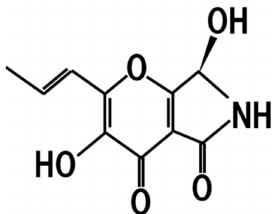
Figure 9. Chemical structure of pyranonigrin-A.